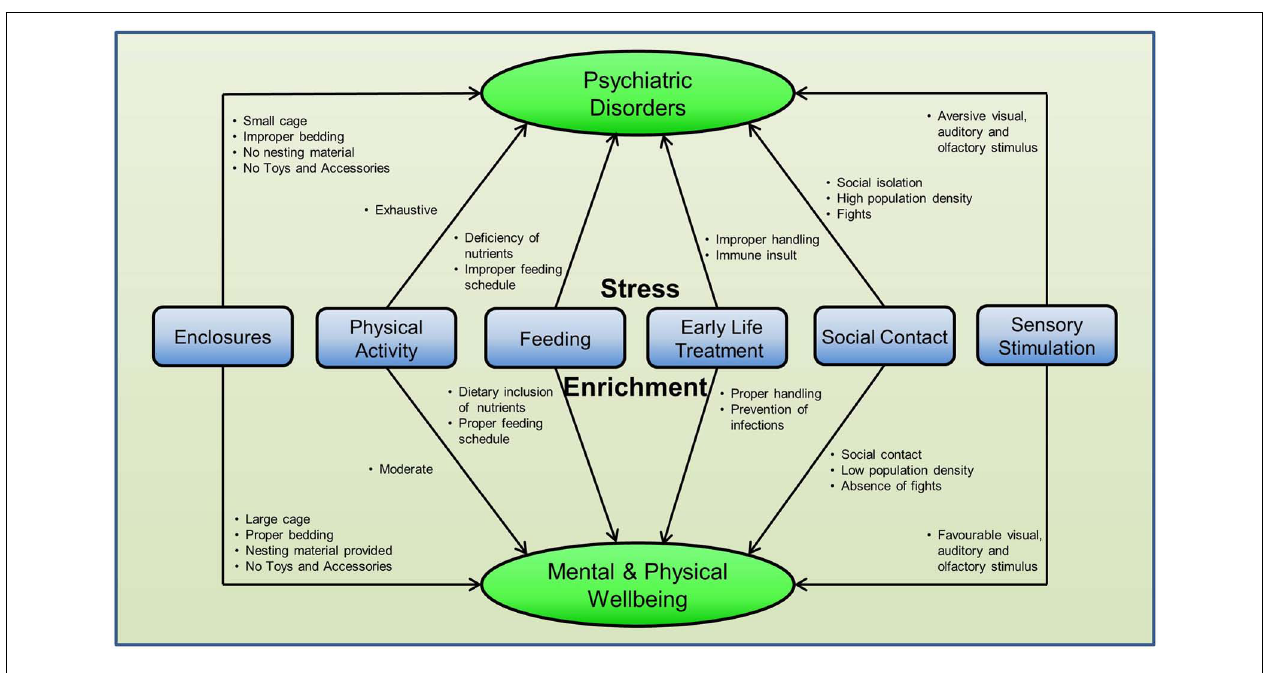
FIGURE 4 | Differential effects of enrichment methods in rodents. The same stressful factor when subtly modified can become enrichment for the animals in captivity. This suggests that